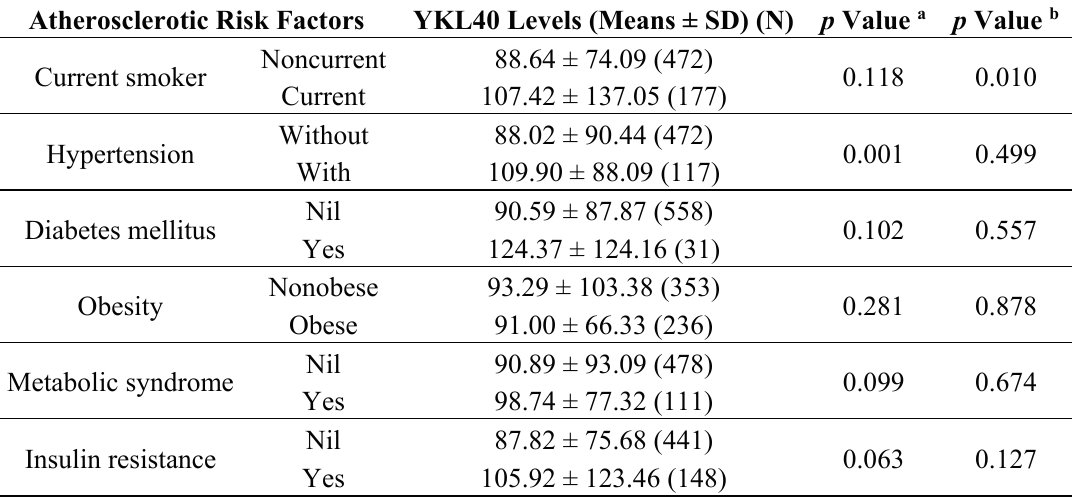
Table 4. Association between YKL40 levels and atherosclerotic risk factors in health examination